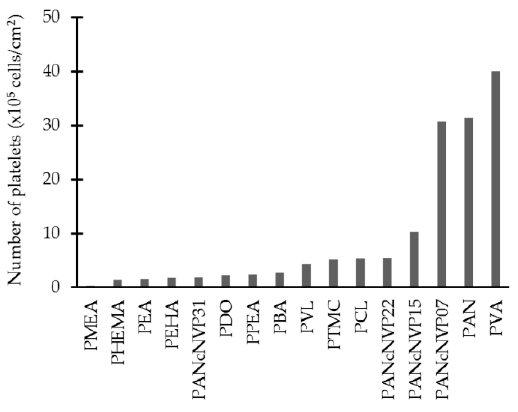
Figure 25. Platelet adhesion on different polymers.